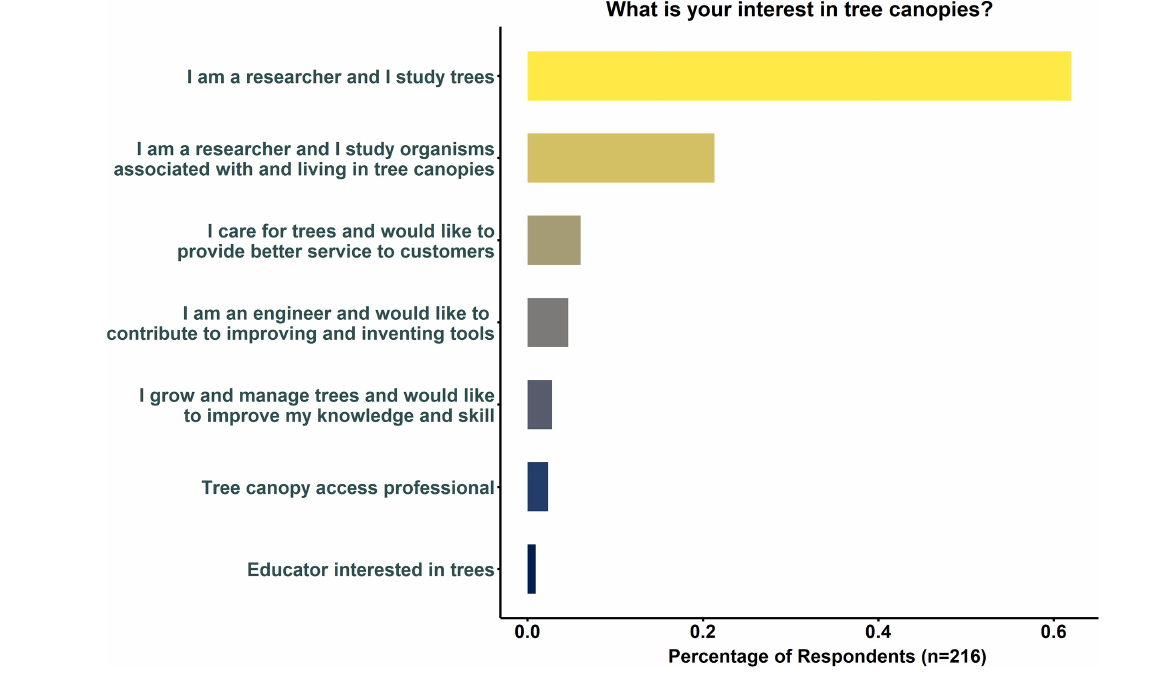
FIGURE 1 | Motivations for gaining access to tree canopies of respondents to an online survey about conducting research and management in the arboreal ecosystem ( n = 216). Each respondent could only choose one option. An “other” option was included, which generated the bottom two answers.